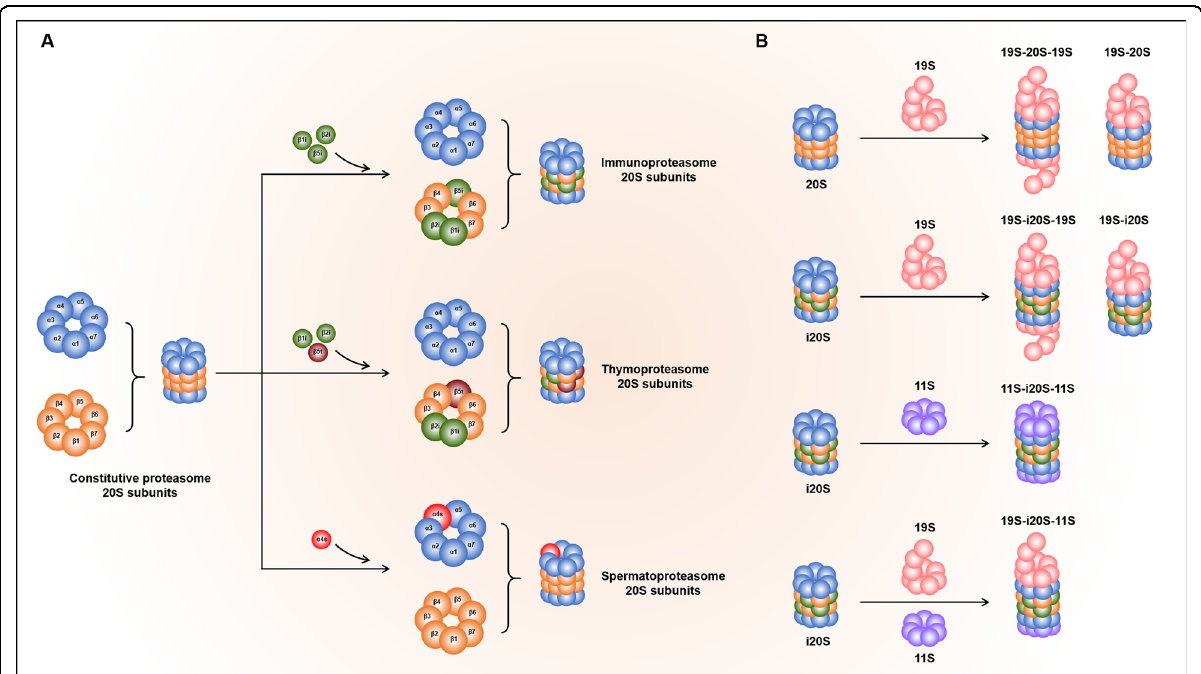
Fig. 1 Different types of proteasome. A Three catalytic subunits β 1, β 2, and β 5 subunits can be replaced by their homologues β 1i, β 2i, and β 5i to form immunoproteasome, β 5t substitutes β 5 to form thymoproteasome, and α 4s subunits replace their constitutive counterparts α 4 to form spermatoproteasome. B The combination of 20 S CP with proteasome activator. The 19 S or 11 S complex can associate at one or both ends of 20 S to form different types of